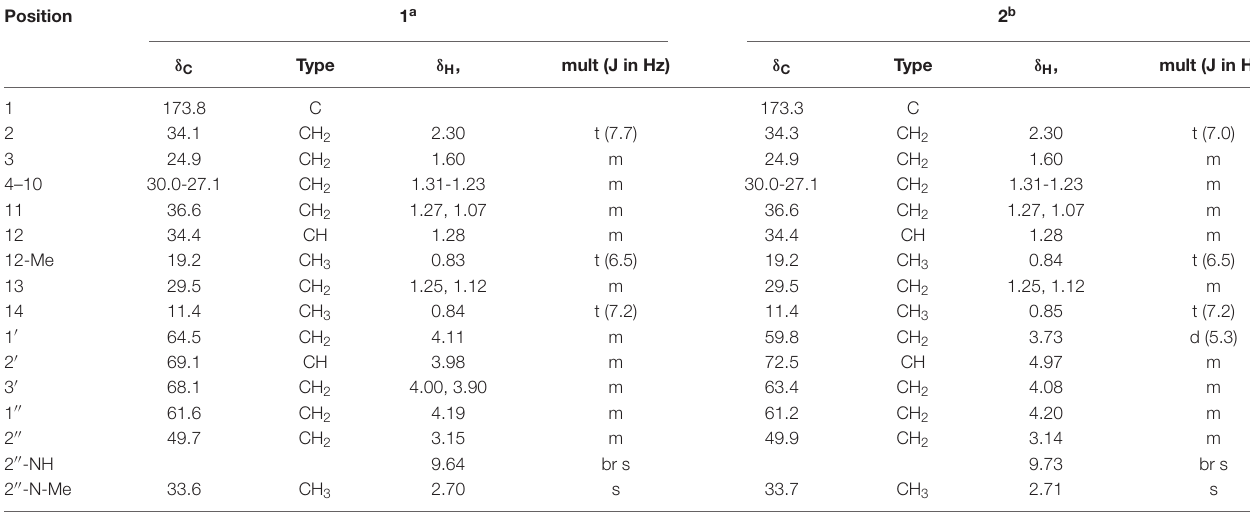
TABLE 1 | 1 H and 13 C NMR spectral data for lenzimycins A and B ( 1 - 2 ) in CDCl 3 . Position 1